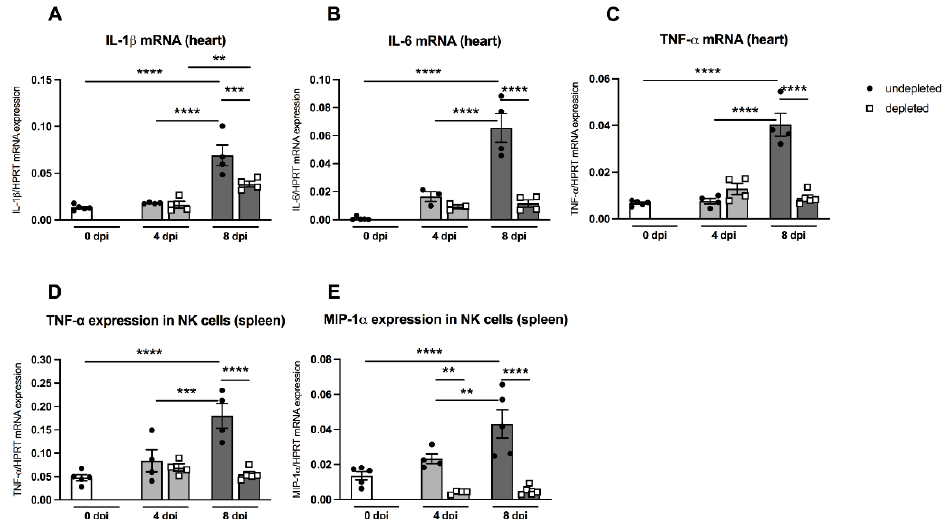
Figure 6. Gr-1 depletion decreases cardiac IL-1 β , IL-6, and TNF- α mRNA levels in CVB3-infected A.BY/SnJ mice. Hearts of Gr-1-depleted and non-depleted CVB3-infected mice were subjected to ( A ) IL-1 β , ( B ) IL-6, and ( C ) TNF- α mRNA quantification by real-time RT-PCR at 0, 4, and 8 dpi. Furthermore, Gr-1 depletion decreases TNF- α , and MIP-1 α mRNA levels in splenic NK cells of CVB3-infected A.BY/SnJ mice. In detail, mRNA levels were quantified in splenic NK cells 0, 4, and 8 dpi of ( D ) TNF- α and ( E ) MIP-1 α after Gr-1 depletion. Data are expressed as mean ± SEM and were analyzed with One-way ANOVA or Kruskal-Wallis test (** p < 0.01, *** p < 0.001, **** p < 0.0001 with n = 5 for 0 dpi, n = 3–4 for 4 dpi, and n = 4–5 for 8 dpi).